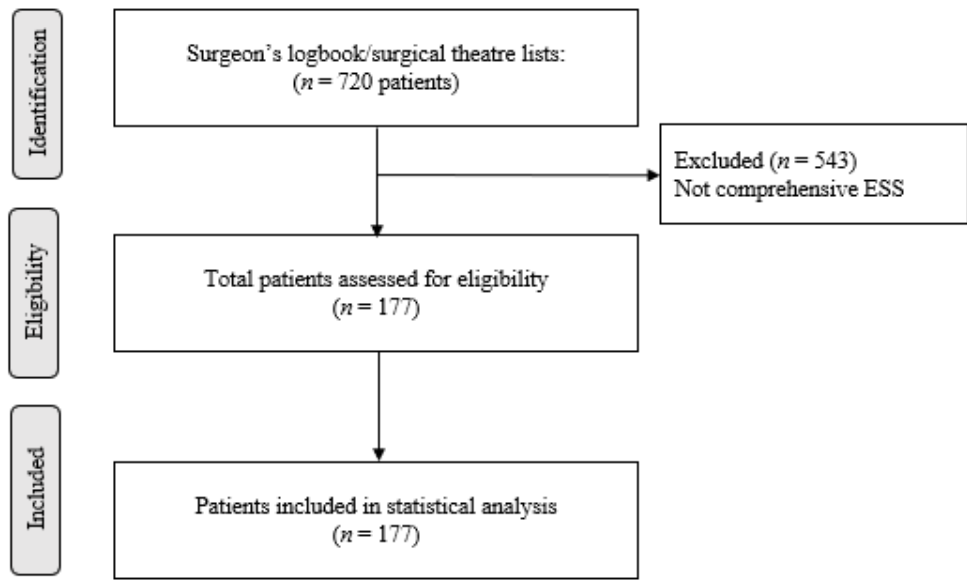
Figure 2. Patient flow chart: retrospective clinical study.